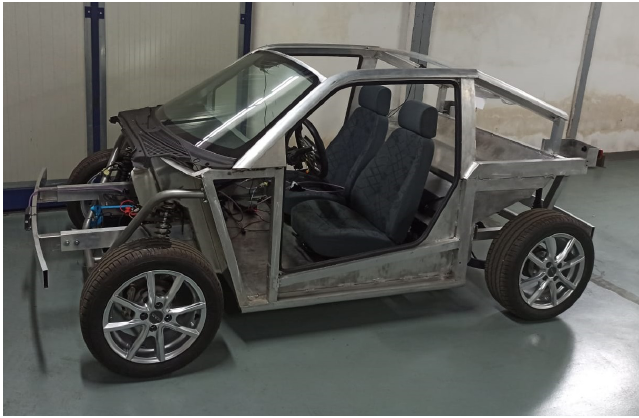
Figure 6. Electric vehicle used for experimental